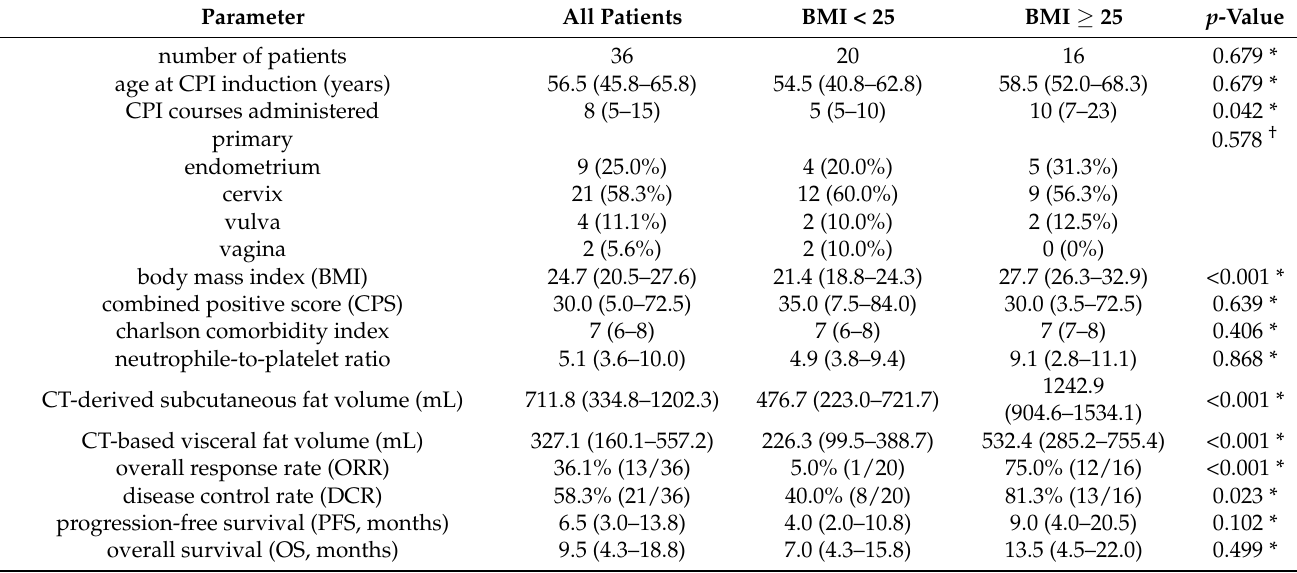
Table 1. Descriptive characteristics of patients with recurrent gynecologic malignancies undergoing treatment with the checkpoint inhibitor (CPI) pembrolizumab depicted by body mass index (BMI). Response rates were assessed by restaging after four courses according to iRECIST criteria. Values are given as median (interquartile range) or number